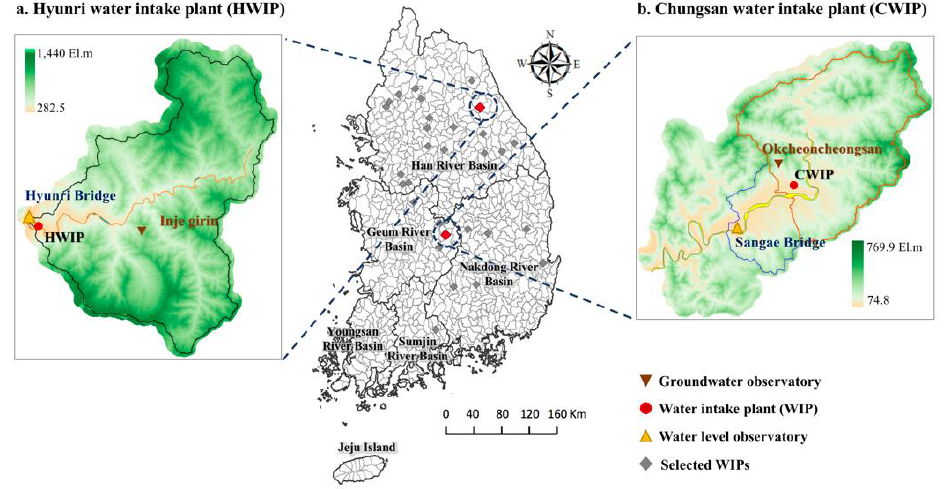
Figure 3. Study area. ( a ) Hyunri water intake plant (HWIP); ( b ) Chungsan water intake plant (CWIP). Gray symbols represent the 21 water intake sites selected in this study.